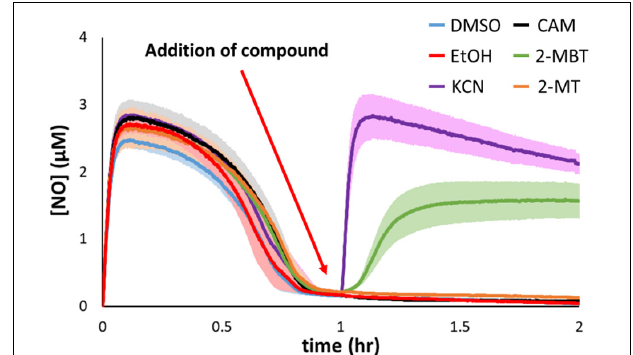
FIGURE 7 | Inhibitory effects of 2-MBT and 2-MT on Hmp catalysis. Following DPTA treatment at time = 0, [NO] was continuously monitored. At time = 1 h, different compounds were added to the bioreactor. DMSO was the solvent for 2-MBT and 2-MT, and EtOH for CAM. KCN is a direct inhibitor of Hmp. Solid lines represent the means of at least 3 independent experiments, and the shaded region the standard errors of the